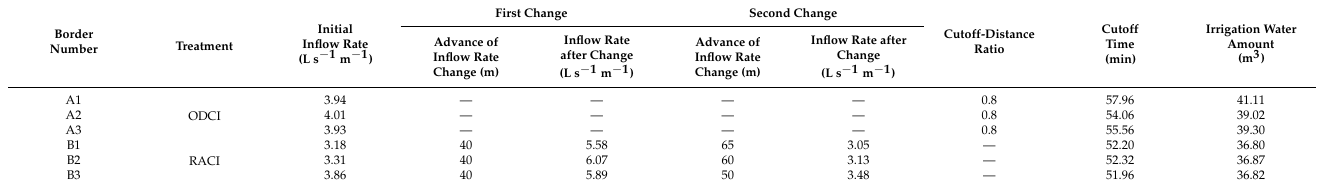
Table 4. Measurement results of inflow rate and irrigation water amount for each border.